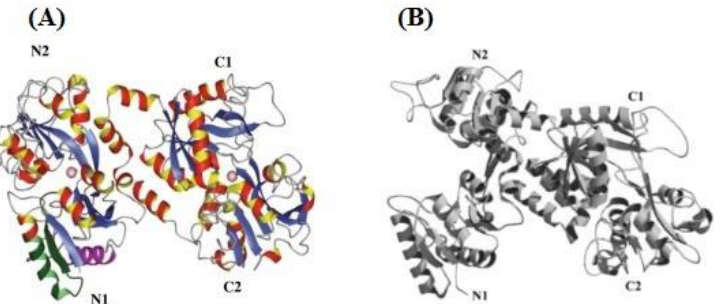
Figure 1. ( A ) Structure of holo-LF (pink spheres represent the iron binding site). ( B ) Structure of apo-LF apo-LF [3].